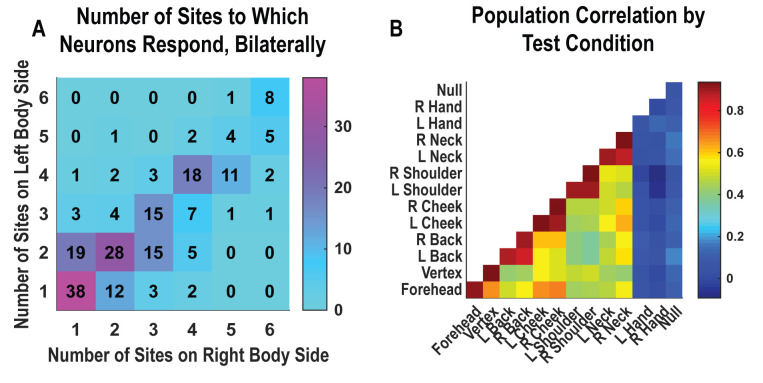
Neurons respond to variable numbers of bilateral receptive fields.Bilateral responses are mirror-symmetric. (A) Matrix showing the number of neurons from within the postcentral-intraparietal population that responded to the number of body parts shown, along each of the left and right body sides. Colors represent the number of neurons. Population results were not qualitatively affected by pooling together single and potential multi-units (Figure 2—figure supplement 1). Analysis of tactile receptive fields is shown in Figure 2—figure supplement 2 and Figure 2—figure supplement 3. (B) Neuronal population correlation demonstrating the relation in encoding structure between body locations. Colors represent strength of correlation, as in the scale. Population results were not qualitatively affected by pooling together single and potential multi-units (Figure 2—figure supplement 4) or by choice of distance metric (Figure 2—figure supplement 5). For mirror-symmetry analysis at the single unit level, see Figure 2—figure supplement 6. L: left body, ipsilateral to implant; R: right body, contralateral to implant.